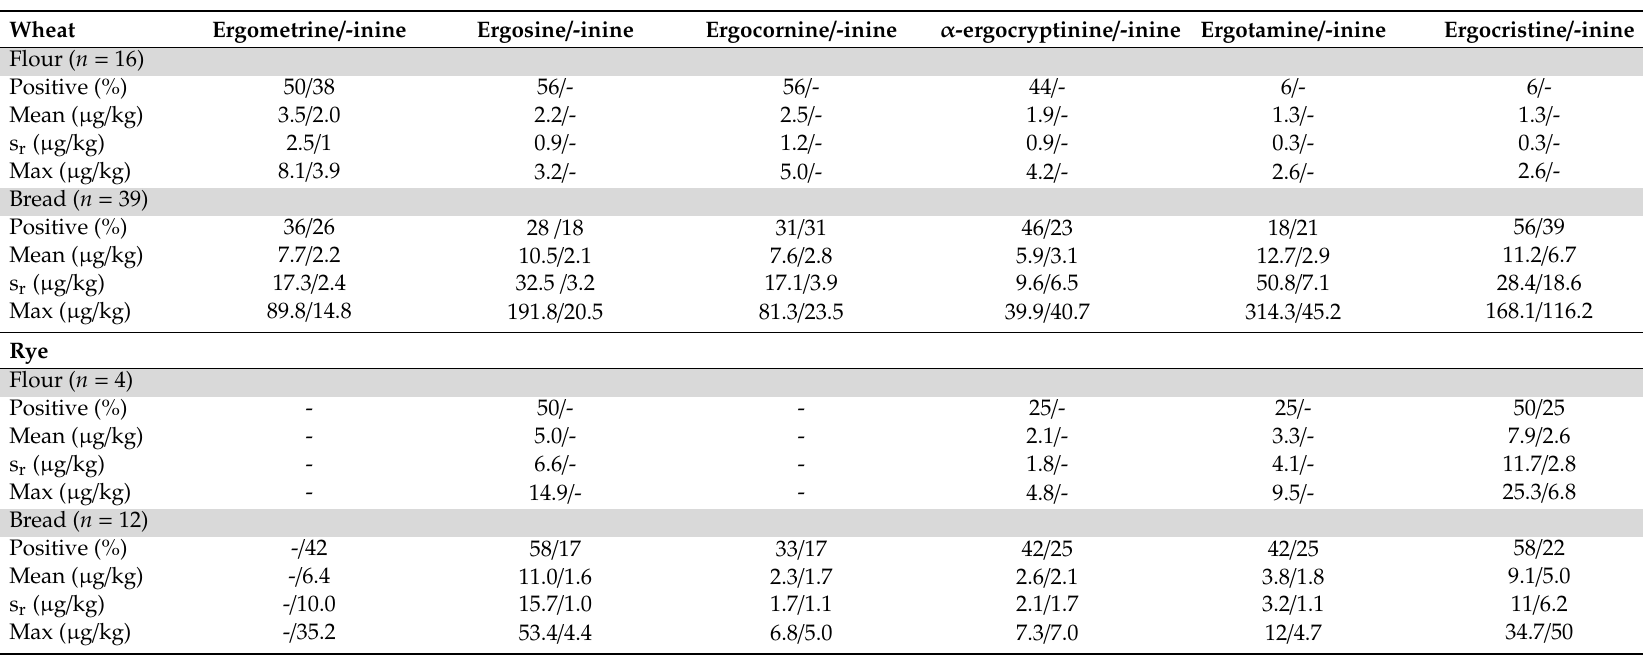
Table 2. The percentage of positive samples, the mean values (calculated with a medium bound approach), the standard deviation and the maximum contamination level obtained for each of the analysed EAs are